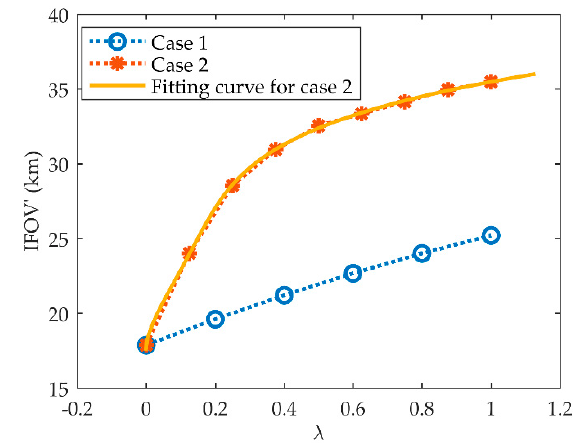
Figure 13. Typical output points of the adjustable network